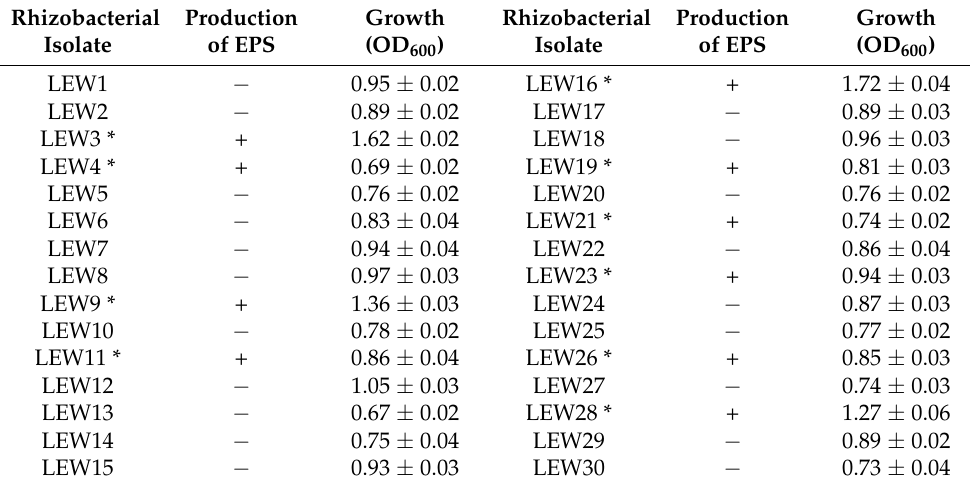
Table 1. Growth in terms of optical density (OD600) and EPS production ability of rhizobacterial isolates in RCV medium.